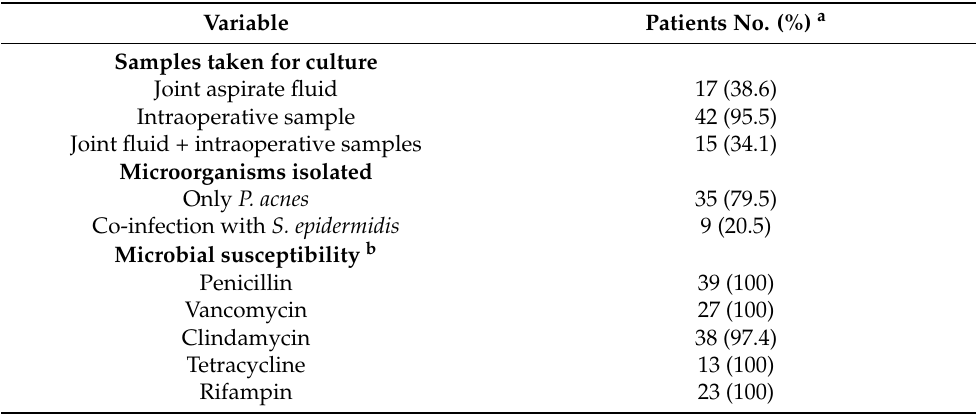
Table 2. Samples and microbiological characteristics of shoulder PJI due to C.